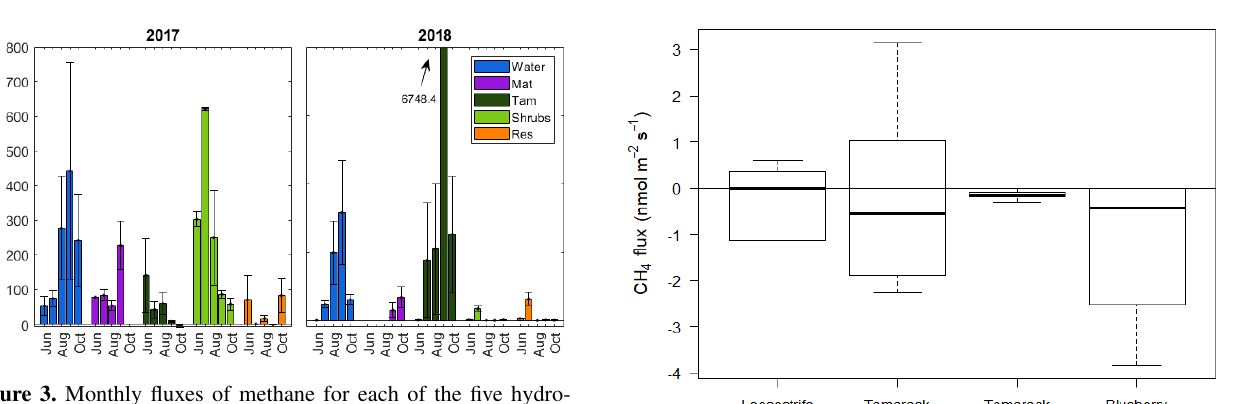
Figure 3. Monthly fluxes of methane for each of the five hydro- biological zones of the study. Fluxes from the Lagg were not sig- nificantly different than zero and are therefore not shown. Standard errors are for all sample locations within the same month and zone (variable number; see Sect. 2.3).